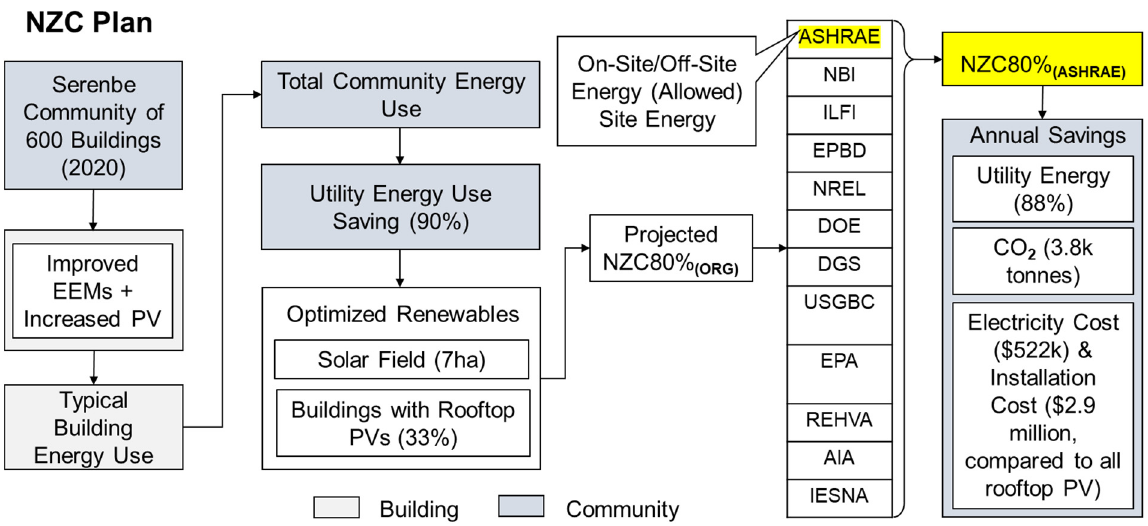
Figure 13. Adapting the NZCX% ( ORG) model to the Serenbe community with 600 buildings in